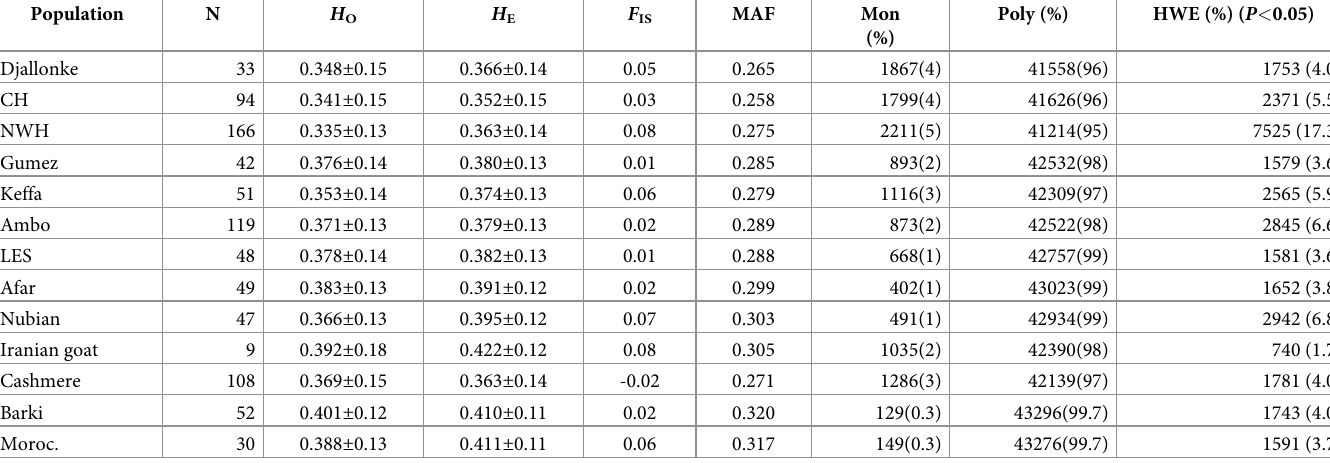
N = no. of samples, NWCH = North-west Highland; CH = Central Highland; Moroc = Moroccan goat; LES = Long-eared Somali; H expected heterozygosity, F IS = inbreeding coefficient, MAF = minor allele frequency, Mono = monomorphic loci; Ply = polymorphic loci; HWE = deviation from Hardy-Weinberg equilibrium.